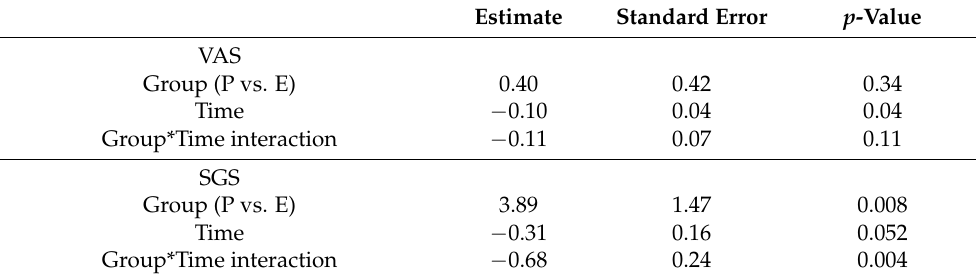
Table 4. Results of the mixed regression models with which VAS, SGS, general pain score and pain evaluation of the operated limb were compared between the groups P (peripheral block of the femoral and sciatic nerves) and E (epidural injection of ropivacaine). In all models, a group effect, a time effect and an interaction effect between group and time were